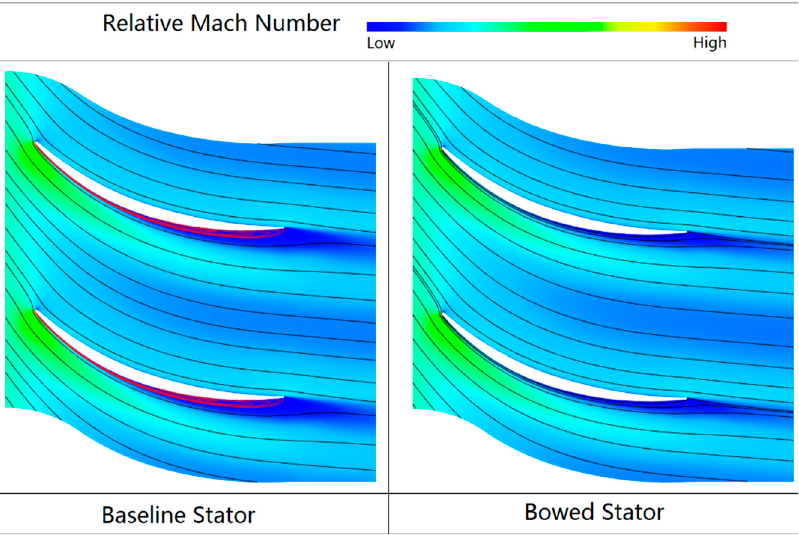
Figure 14. Relative Mach number contours and streamlines at the 35% span of stator 5 (near the stall